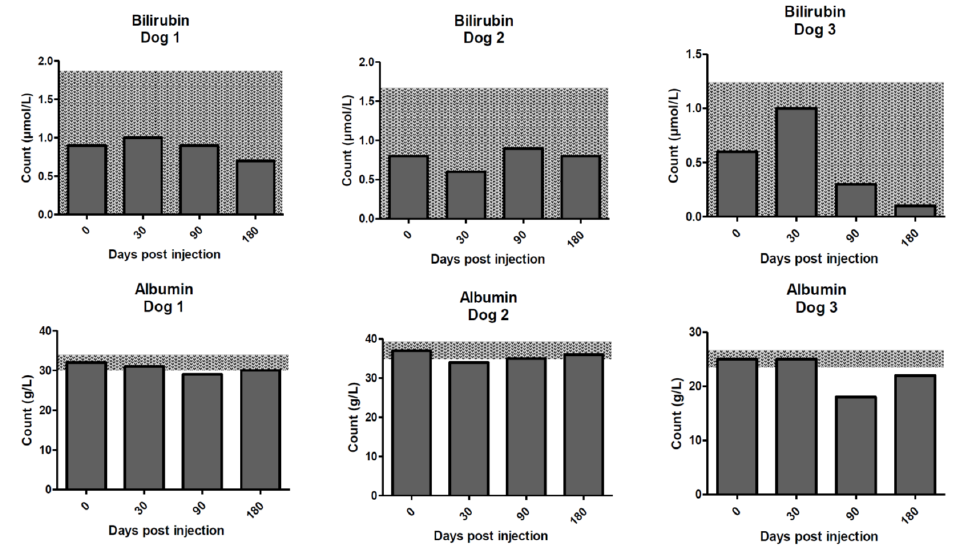
Figure 7. Bilirubin and albumin concentrations for the dogs on days 0–180 post treatment with 213 Bi-400-2 antibody. Upper row—bilirubin; lower row—albumin. Shaded areas show reference change values (RCVs).